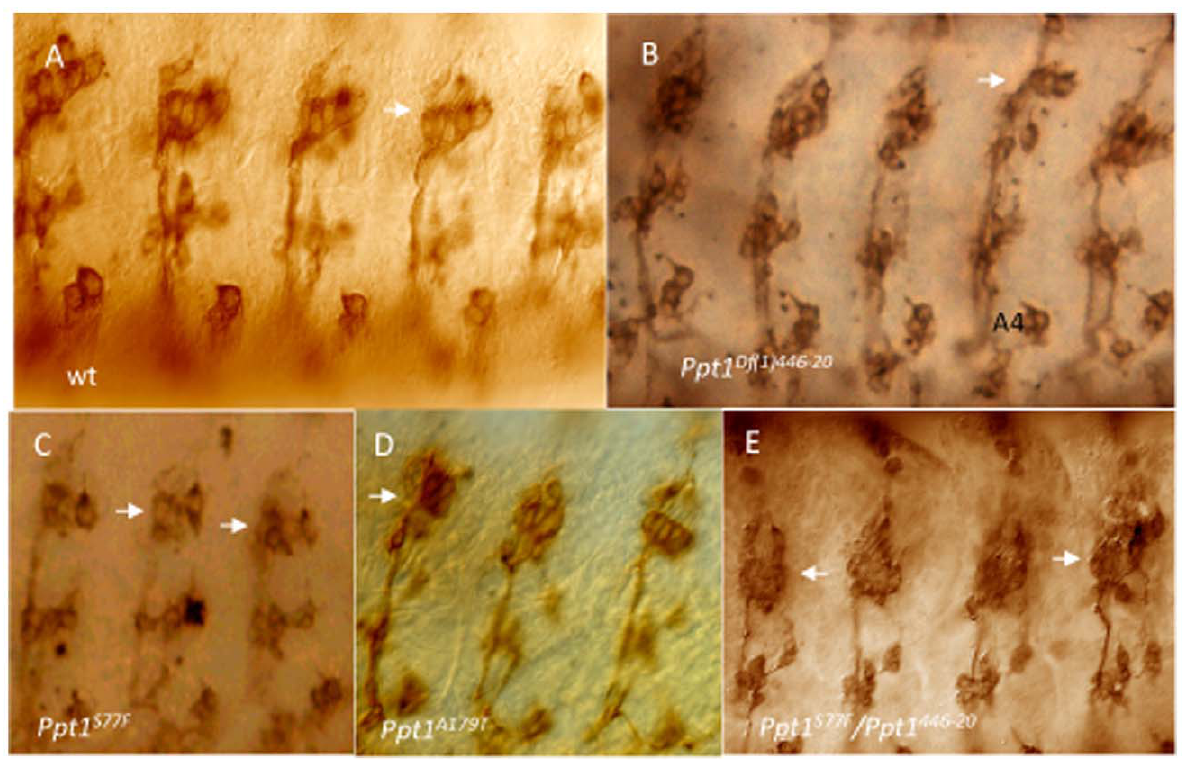
Figure 6. Chordotonal neurons (lch5) in the developing PNS are abnormal in many Ppt1 LOF embryos. In all panels, lch5 neurons are indicated by the arrows. Side view of S17 embryos stained with Mab 22C10. (A) Wild type clusters of lch5, v, and v 9 neurons are located in every abdominal segment. (B–E) lch5 neurons in mutant Ppt1 embryos demonstrate a variety of defects: decreased number of neurons (B), fused and abnormally shaped (D, E), organization and positional defects, and thin axon bundles (black arrowhead) (B and C). dorsal, up. doi:10.1371/journal.pone.0014402.g006 PLoS ONE |